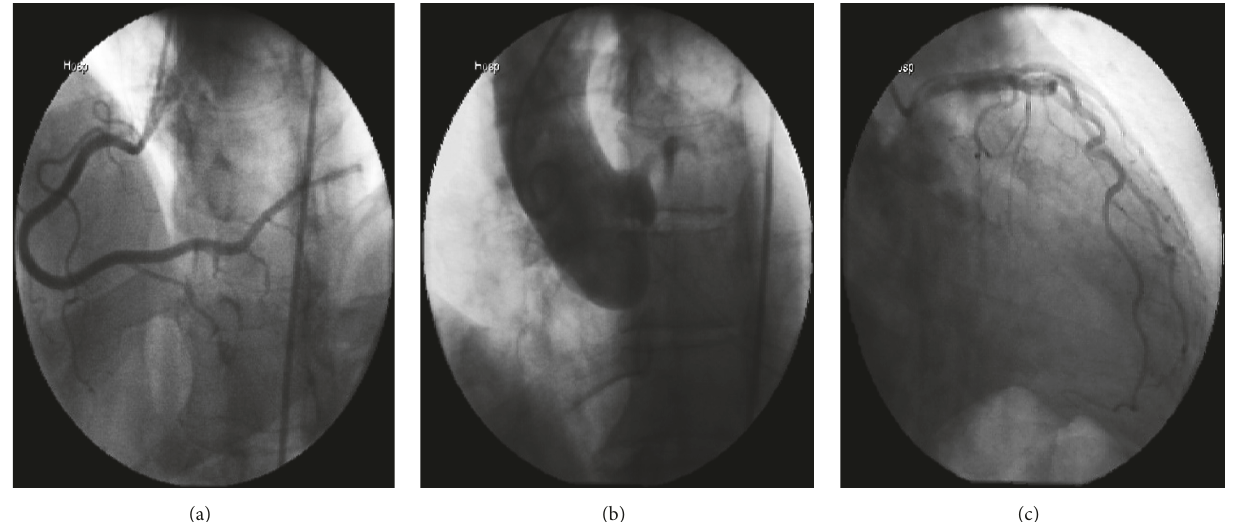
Figure 2: Coronary angiogram: (a) LAO-CAU view of superdominant RCA, (b) aortic root shot to rule out anomalous origin of the LCX, and (c) RAO caudal view showing absent left circumflex in the AV groove.